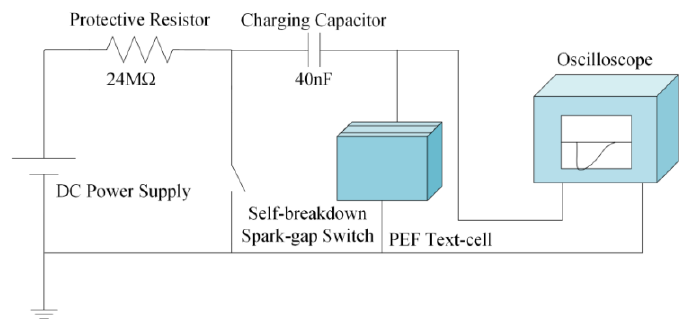
Figure 4. Circuit diagram of the PEF system.